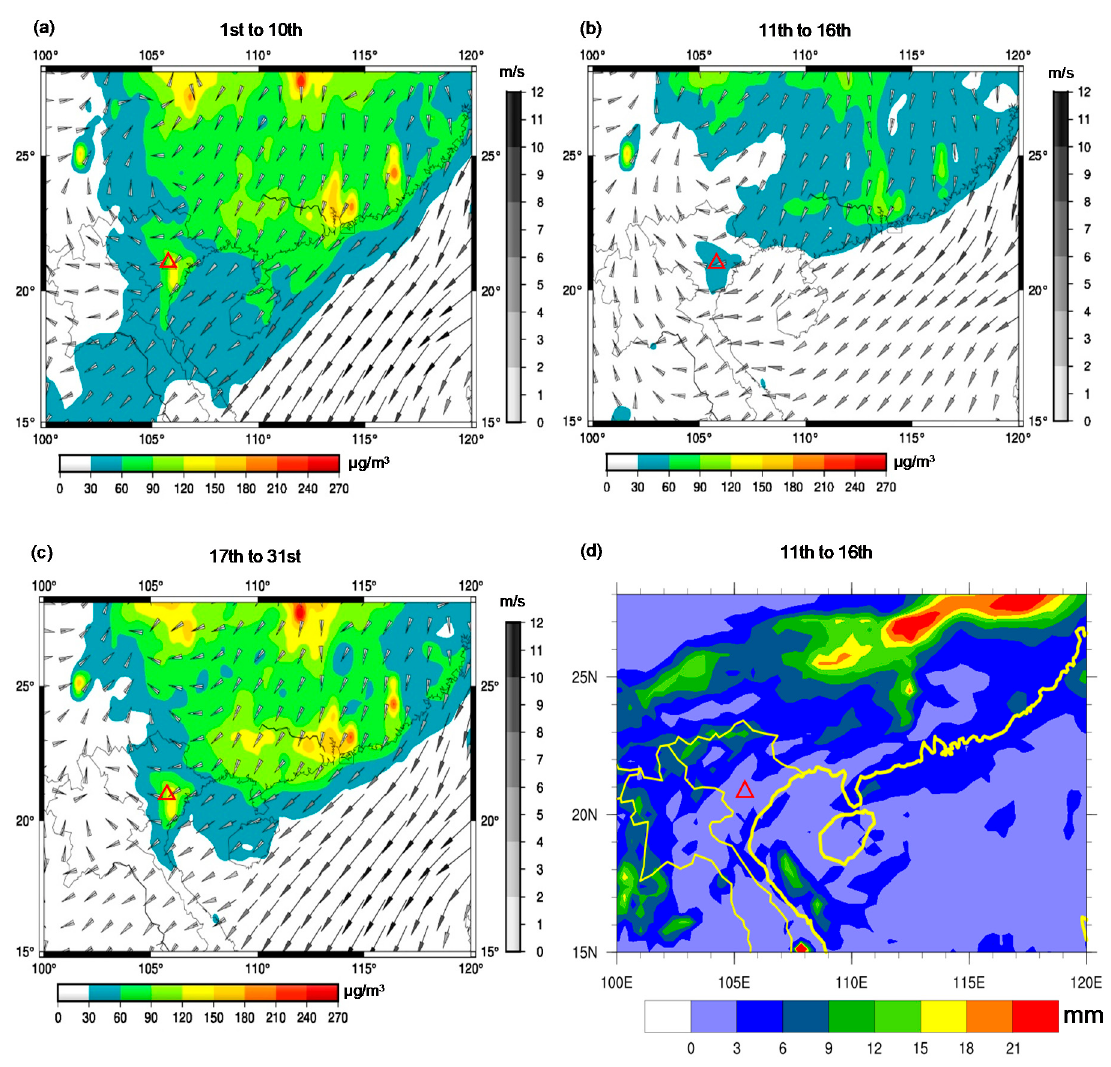
Figure 8. Simulated surface concentrations of hourly mean PM 2.5 concentration, WS and WD ( a ) from 1 to 10 December; ( b ) from 11 to 16 December; ( c ) from 17 to 31 December 2010; and ( d ) daily mean precipitation from 11 to 16 December. The red triangle in each map represents the center of Hanoi.